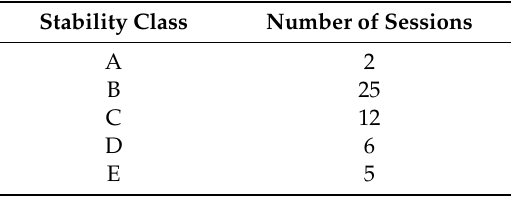
Table 2. Summary of Pasquill stability classes for 51 field odour assessment